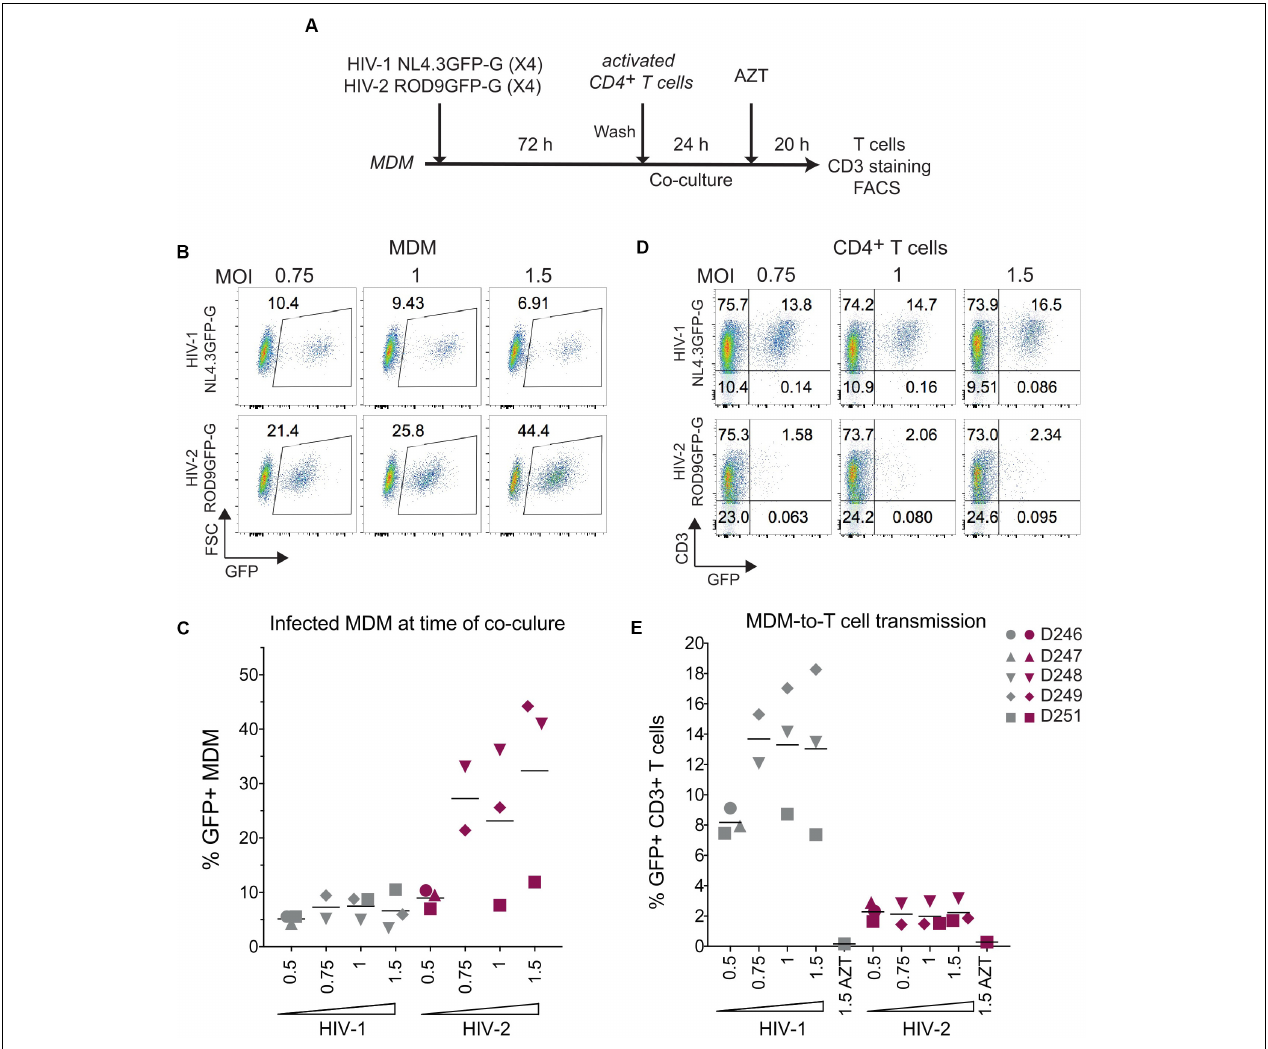
FIGURE 5 | HIV-2 transmission from infected MDM to activated CD4 + T cells is inefficient. (A) Macrophage-to-T cell transmission, outline of the experiment. (B) Representative dot plot of GFP expression of HIV-infected MDMs analysed at 3 dpi by flow cytometry. Percentages of GFP + cells are indicated in the gates. (C) Percentages of GFP + MDMs at 3 dpi as in (B) , n = 5 donors from 3 independent experiments, bars representing the mean. (D) Representative dot plots of GFP and CD3 expression at the end of the 44 h co-culture. (E) Percentages of CD3 + GFP + T cells after co-culture with infected MDM as in (D) , n = 5 donors from 3 independent experiments, bars representing the